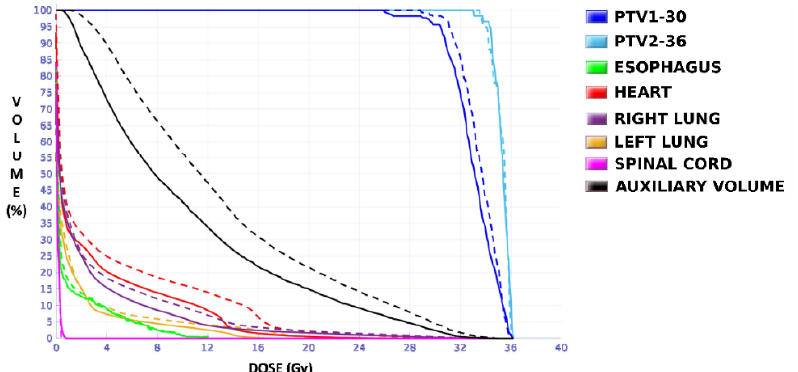
and EARL2 ( right ) accreditations.